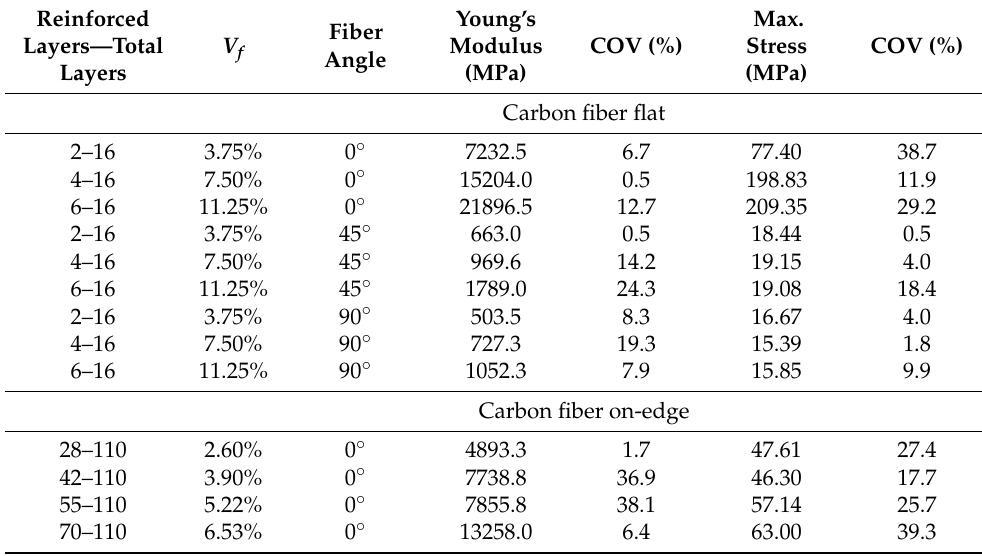
Table 2. Results for continuous carbon fiber reinforced Nylon